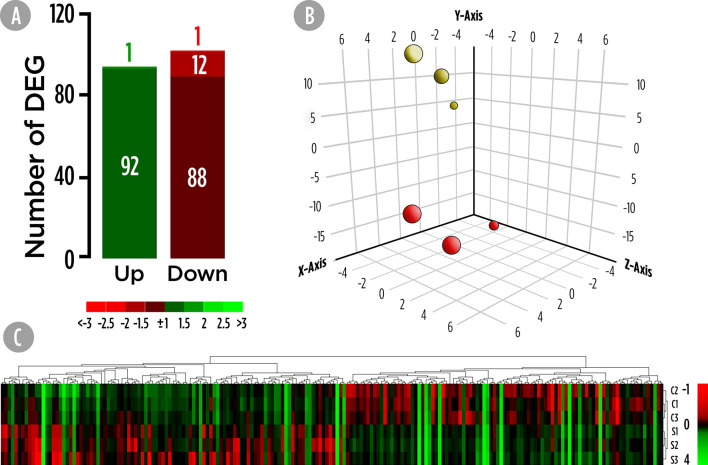
Skin mucus microrrays-based transcriptomic analysis for gilthead sea bream fed with SDPP supplemented diet. (A) Number of total differential expressed genes (DEGs). The green (upregulation) and red (downregulation) color scheme indicates the gene modulation according to its fold-change magnitude interval. (B) Principal component analysis (PCA). Control (red spheres) and SDPP groups (yellow spheres) are represented. (C) Hierarchical clustering heatmap representing the 194 DEGs. The normalized intensity values (log2) obtained for each microarray analyzed for control (C1, C2, and C3) and SDPP group (S1, S2, and S3) are shown.